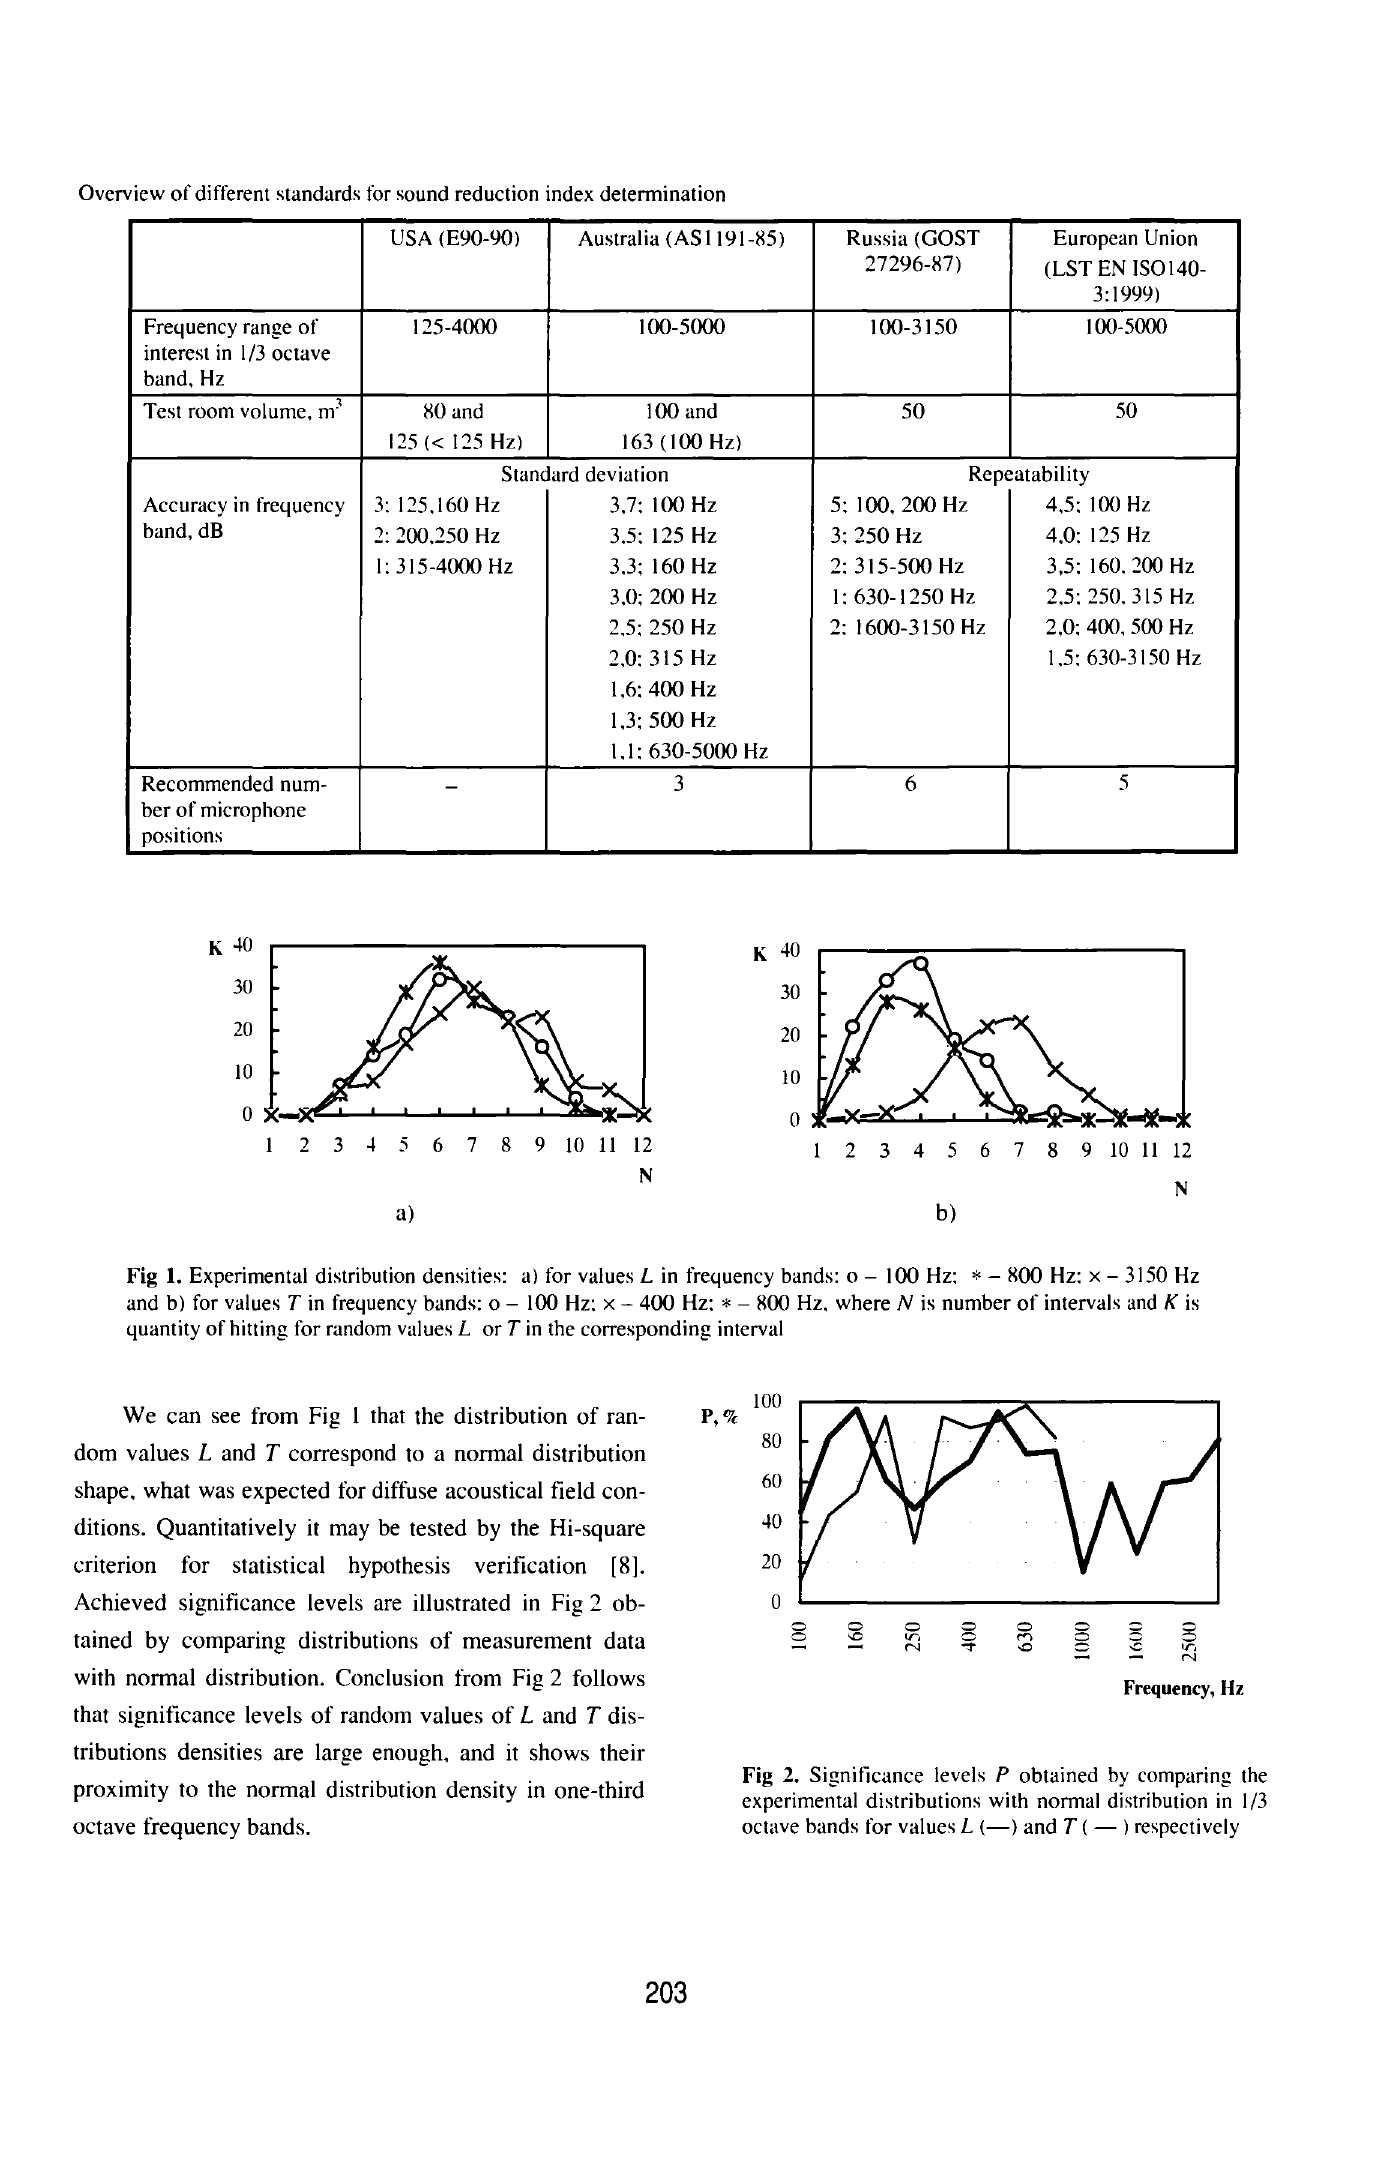
Fig 1. Experimental distribution densities: a) for values L in frequency bands: o - I 00 Hz: * - ROO Hz: x- 3150 Hz and b) for values Tin frequency bands: o- 100Hz: x- 400Hz: *-ROO Hz. where N is number of intervals and K is